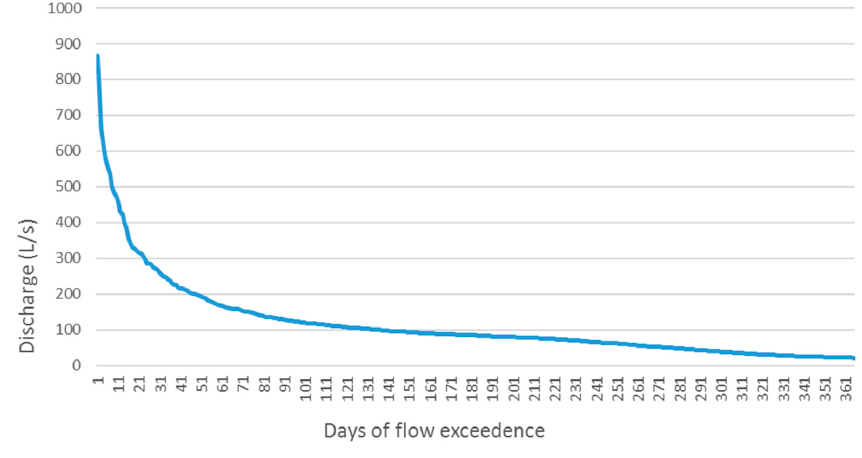
Figure 8. Calculated average flow duration curve, 2012–2015.